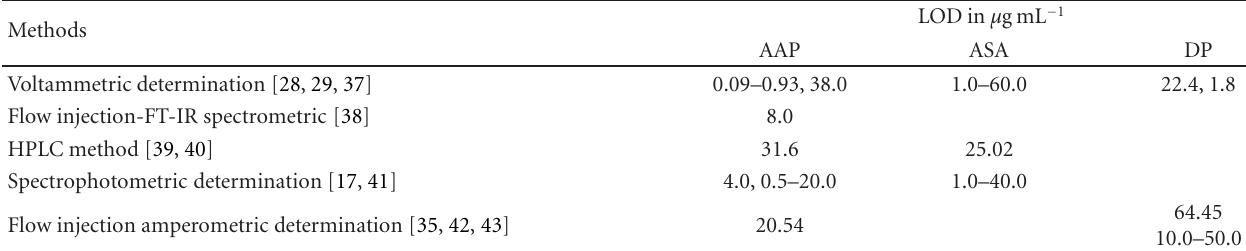
Table 4: Comparison of available